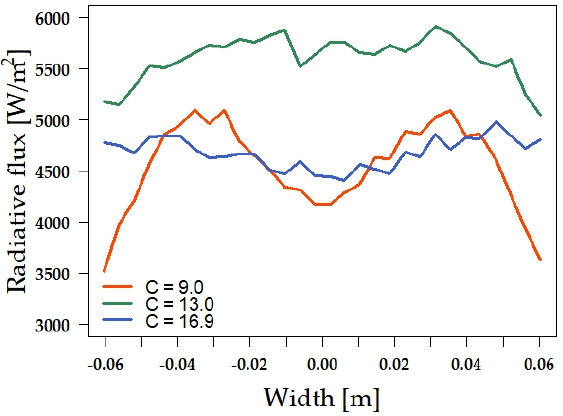
Figure 9. Cross-section radiative flux distribution for four different concentration ratios.